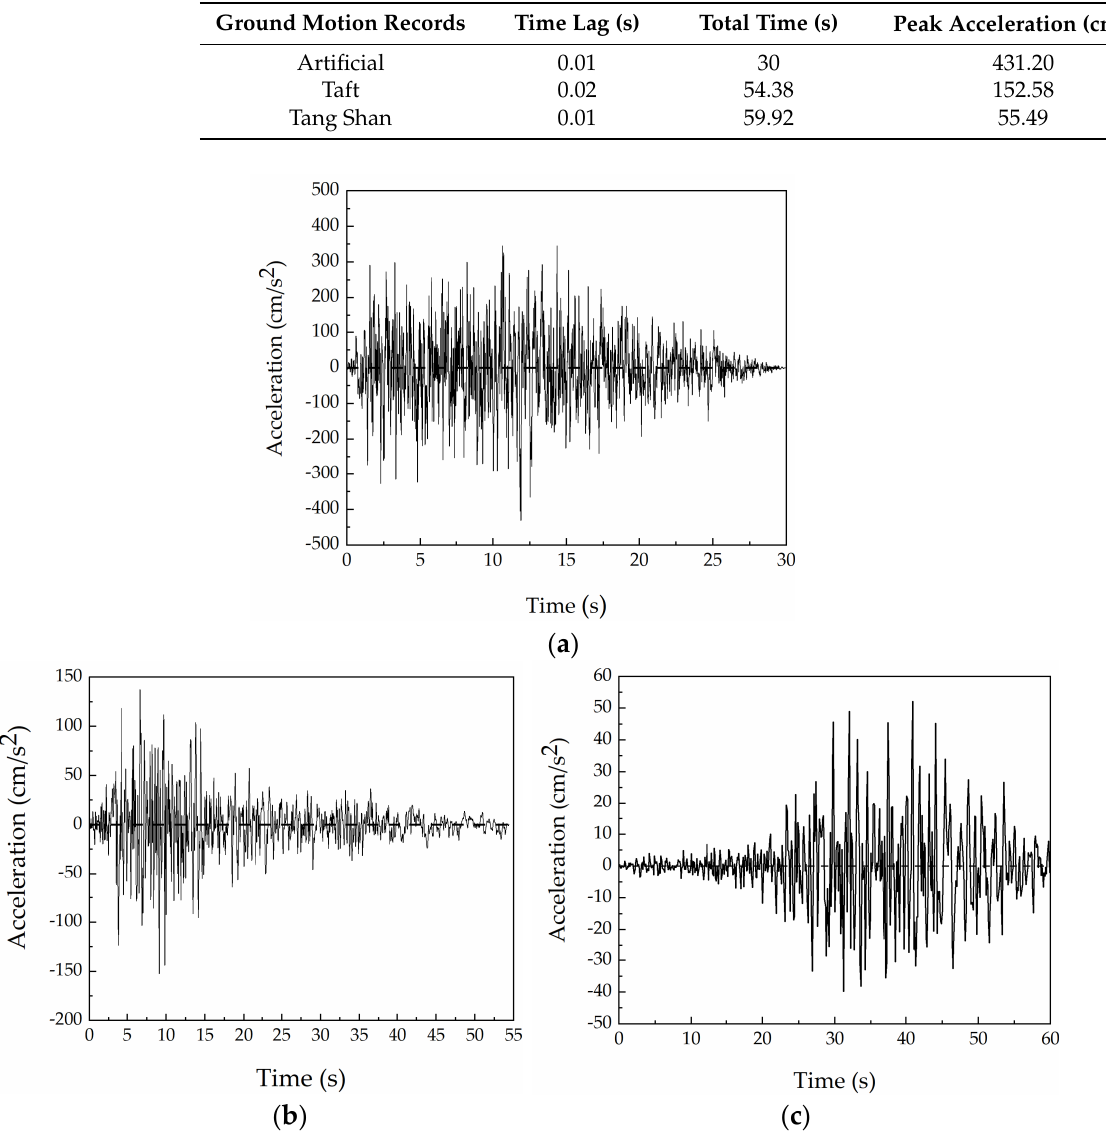
Figure 11. The earthquake ground motions: ( a ) Artificial ground motion record; ( b ) Taft ground motion record; ( c ) Tang Shan ground motion record.